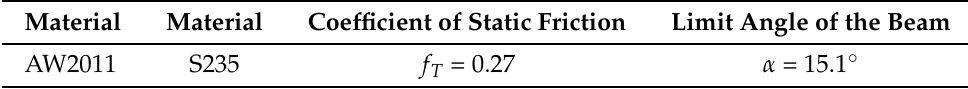
Figure 3. The used coefficient of static friction is presented in Table 4. Table 4. Coefficient of friction between AW2011 and S235.